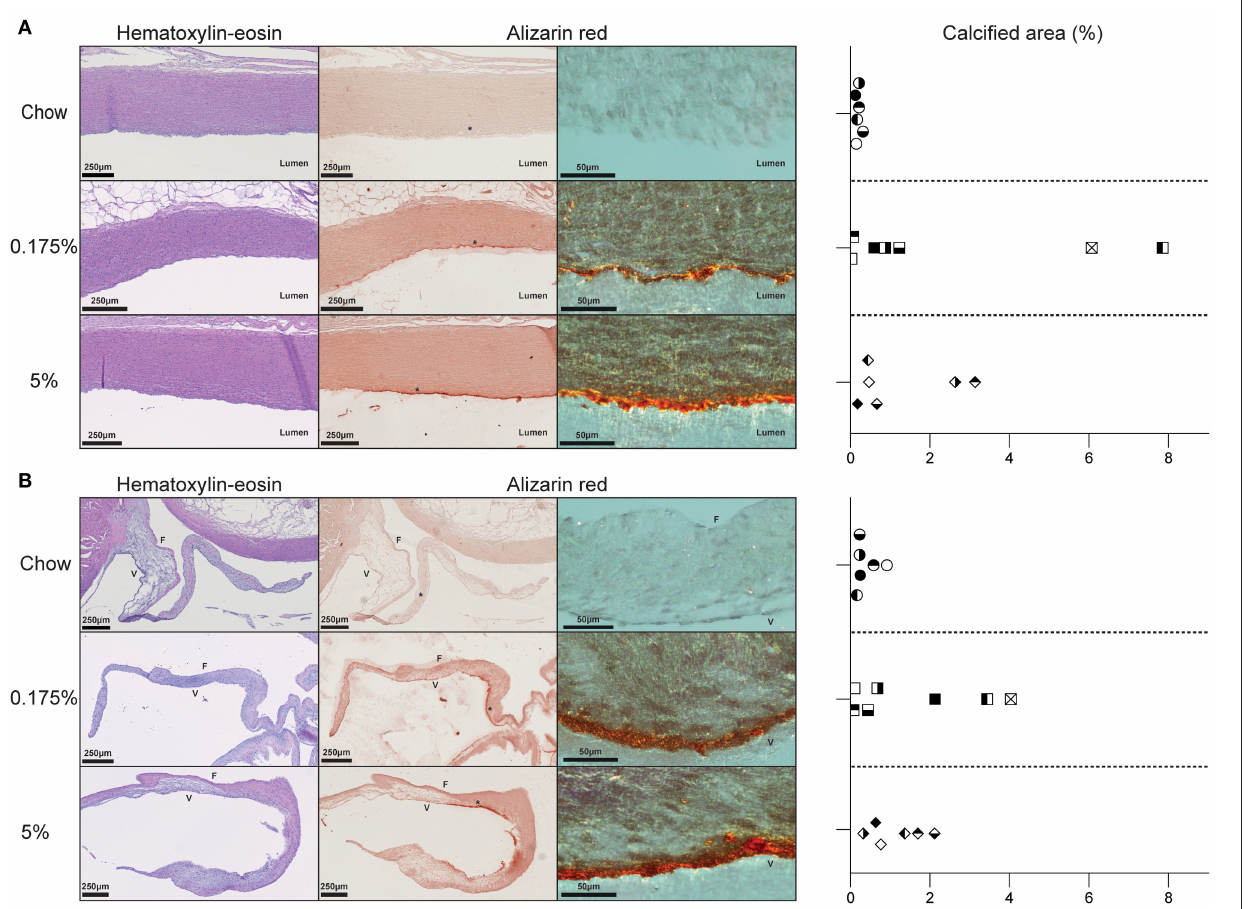
FIGURE 1 | Effect of PA and PA/OA enriched diets on rabbit aorta and aortic valve structures. (A) . Representative pictures of aortic wall for chow, 0.175% and 5% lard diet groups stained with hematoxylin-eosin or alizarin red. Graph represents the percentages of calcified areas in aorta in all three rabbit groups. (B) . Representative pictures of aortic valve of chow, 0.175% and 5% lard diet groups stained with hematoxylin-eosin, hematoxylin-eosin or alizarin red. Graph represents the percentages of calcified areas in aortic valve in all three rabbit groups. Alizarin red pictures are taken with light microscopy (left panels) and with polarized light microscopy at higher magnification of * zone (right panels). In graphs, one symbol corresponds to one